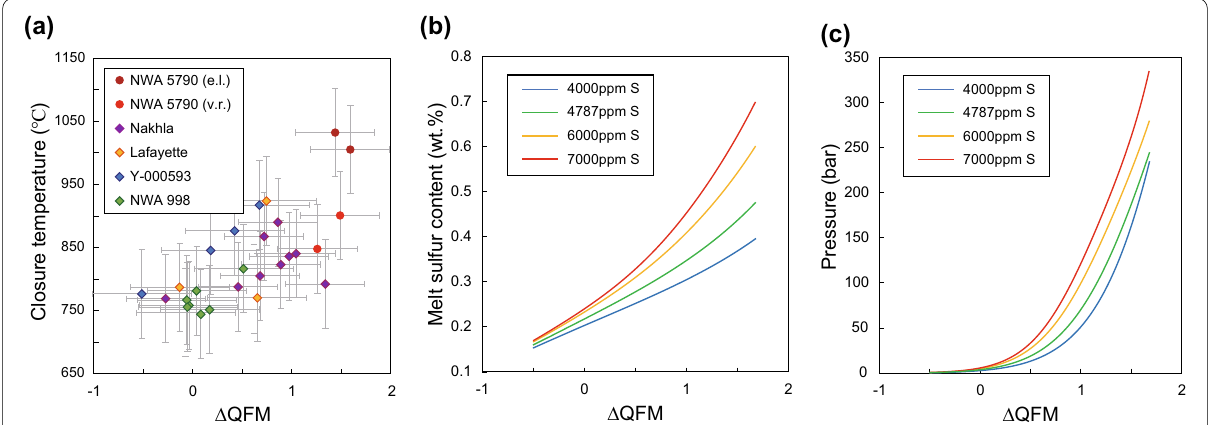
Fig. 2 a Closure temperature and f O 2 (relative to QFM buffer) for NWA 5790 nakhlite titanomagnetite–ilmenite pairs in this study (red dots), compared to closure temperature and f O 2 from titanomagnetite–ilmenite pairs in nakhlites from the literature (Boctor et al. 1976; Bunch and Reid 1975; Sautter et al. 2002; Szymanski et al. 2010; Treiman and Irving 2008). All closure temperatures and f O 2 were recalculated using geothermometer and oxybarometer in Sauerzapf et al. (2008). Error bars for temperature and f O 2 are 70 °C and 0.5log f O 2 unit, respectively. b Total sulphur ± ± content vs. f O 2 (expressed as ΔQFM) degassing simulations. c Pressure vs. f O 2 (expressed as ΔQFM) degassing simulations. Degassing models calculated by D-Compress are in an open C–S–O–H system. For close-system degassing curves, see Additional file 1: Figure